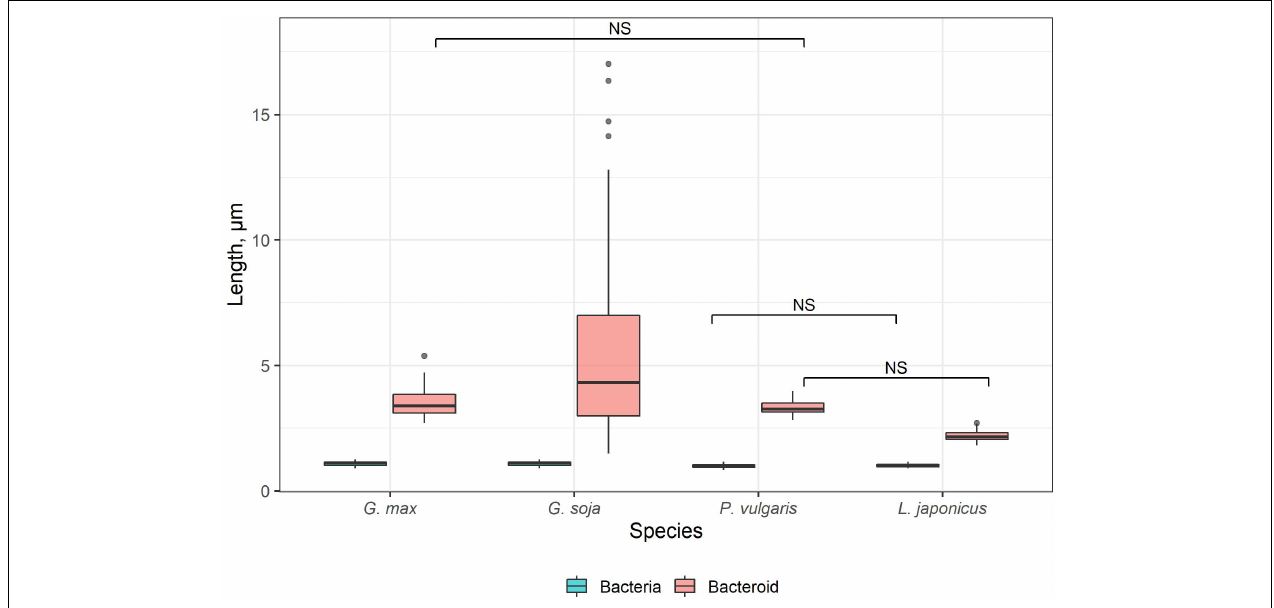
FIGURE 2 | Length of free-living bacteria and bacteroids in nitrogen-fixing cells of G. max , G. soja , P. vulgaris, and L. japonicus nodules. Pairwise comparisons were conducted using Tukey’s range test. NS indicates not significant differences ( p > 0.05); n = 50 (for G. soja n = 165 due to the high variation of bacteroid length).